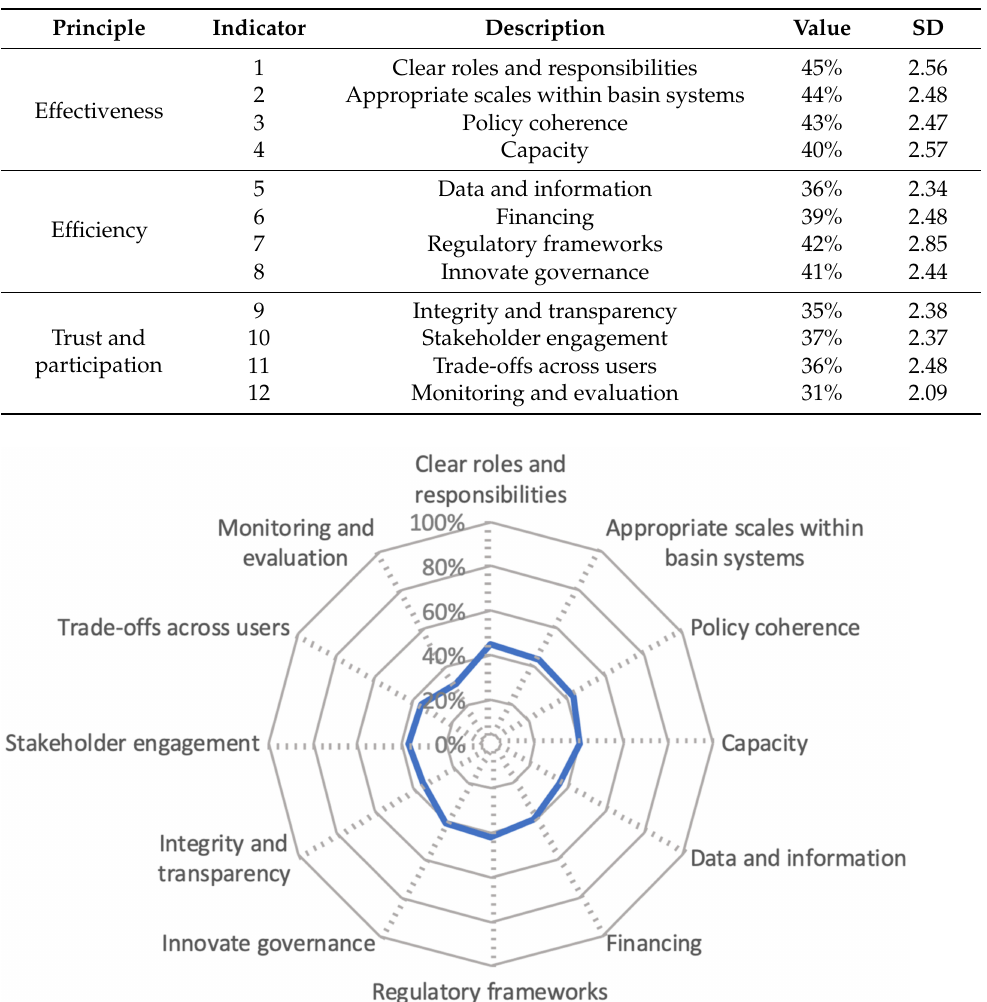
Table 3. Results of indicators and research to support them [2].